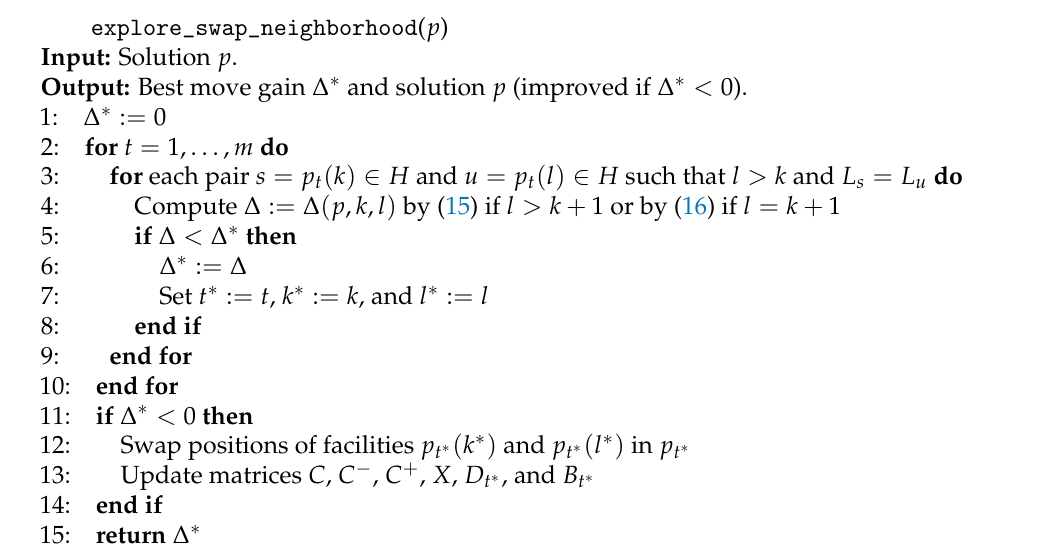
Algorithm 5 Swap neighborhood exploration